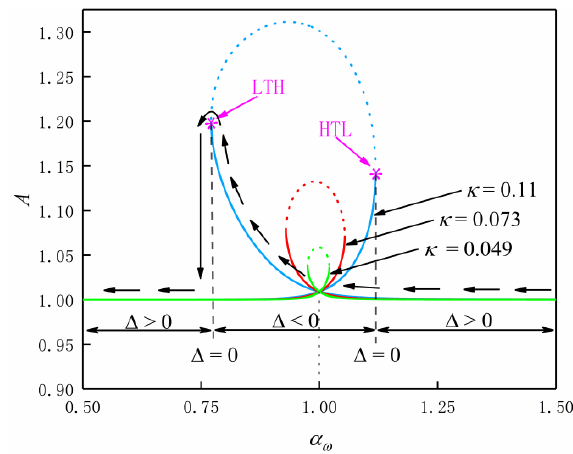
Figure 9. Amplification factor of the operational amplifier (OP) Amp versus α ω at detuning. In Figure 9, there is a dotted curve in the middle of each curve. Each dotted curve corresponds